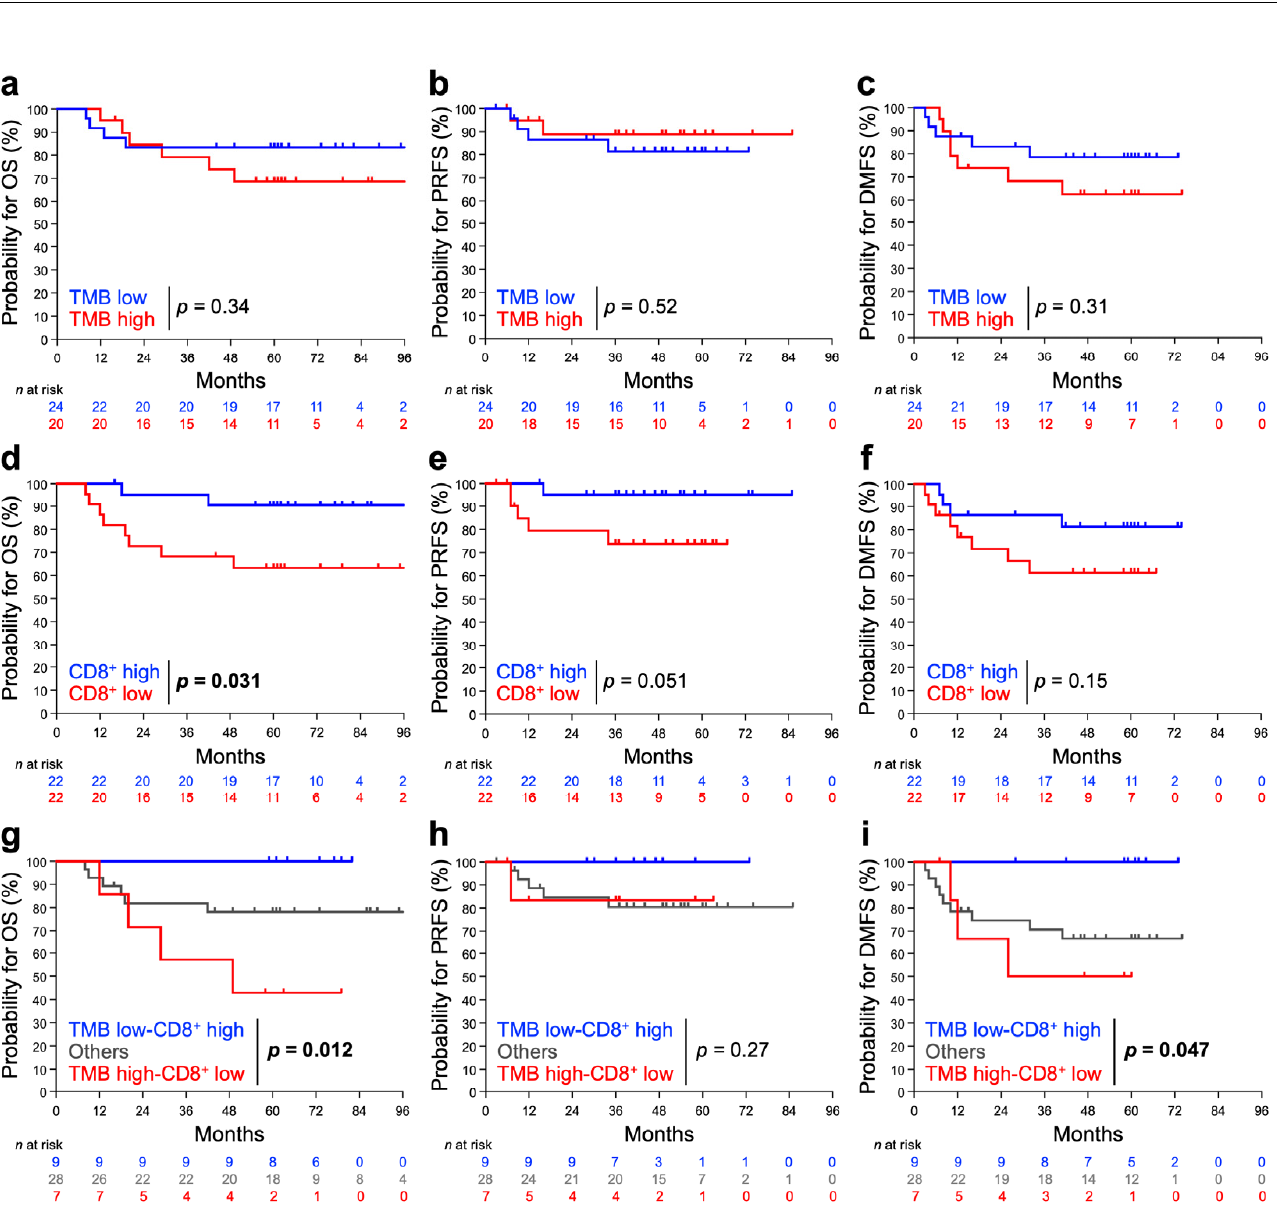
Figure 3. Probability of OS, PRFS, and DMFS stratified by TMB ( a – c ), pre-RT CD8 + TIL density ( d – f ), or the two factors in combination ( g – i ). ( a , d , g ) OS. ( b , e , h ) PRFS. ( c , f , i ) DMSF. The patients were dichotomized with TMB or with pre-RT CD8 + TIL density using the median: 9.5 mut/Mb and 22.5%, respectively. p values assessed by the log-rank test are shown.